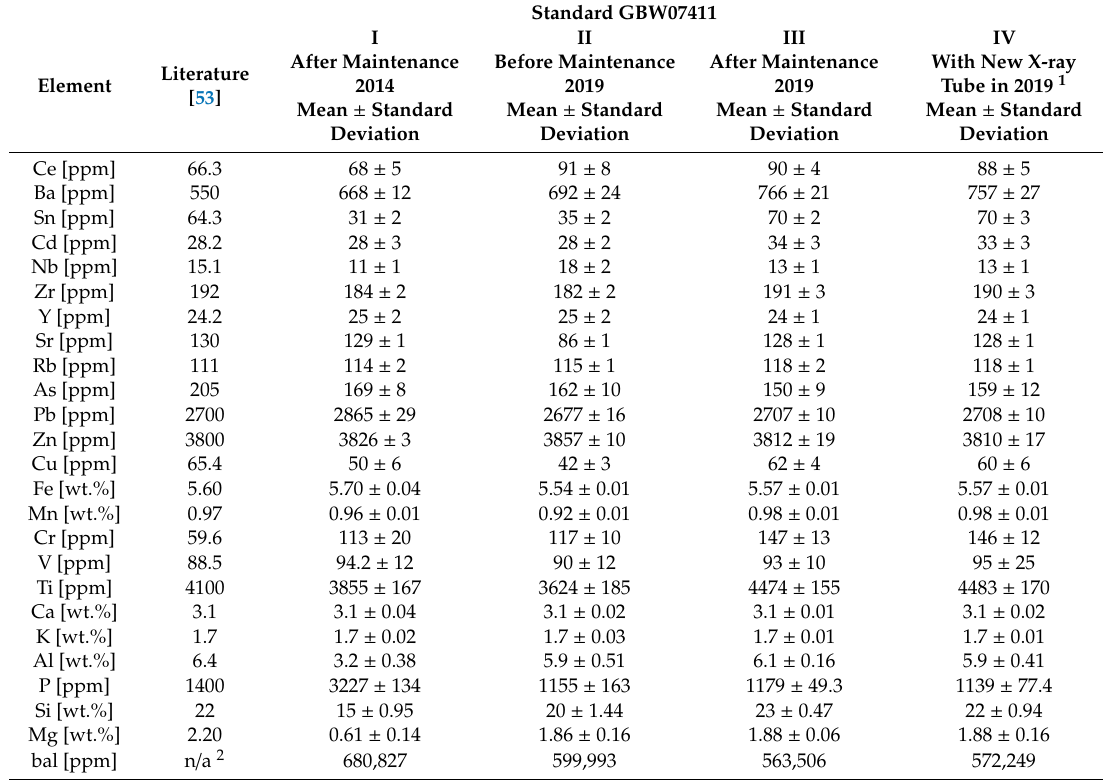
Table 2. Element concentrations of GBW04711 (literature values) and measured as unknown sample.